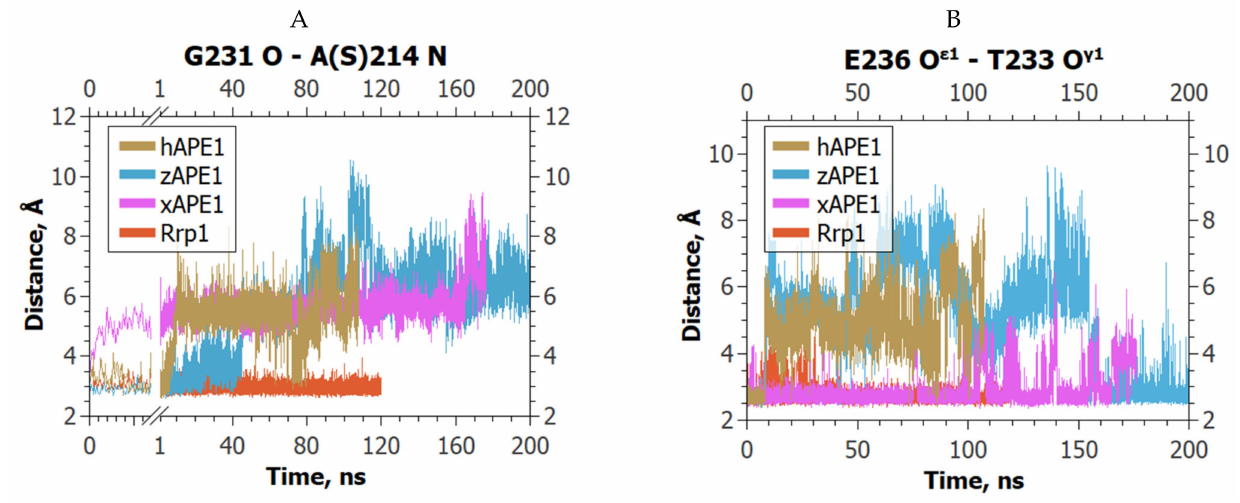
Figure 7. The dynamics of ( A ) Gly231 O–Ala214 N and ( B ) Thr233 O γ 1 –Glu236 O ε 1 distances in the complexes of the APE1-like enzymes with α A-containing